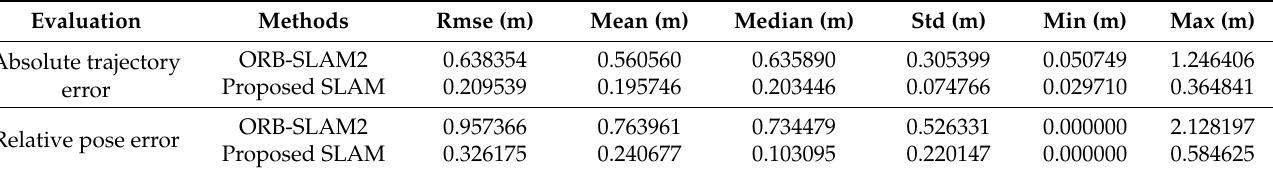
Table 6. Pose error representative value of dataset two.